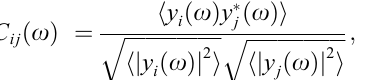
; ð 1 Þ ffiffiffiffiffiffiffiffiffiffiffiffiffiffiffiffiffiffiffi q ffiffiffiffiffiffiffiffiffiffiffiffiffiffiffiffiffiffiffi q hj y ð x Þj 2 i ð x Þj 2 i hj y i j